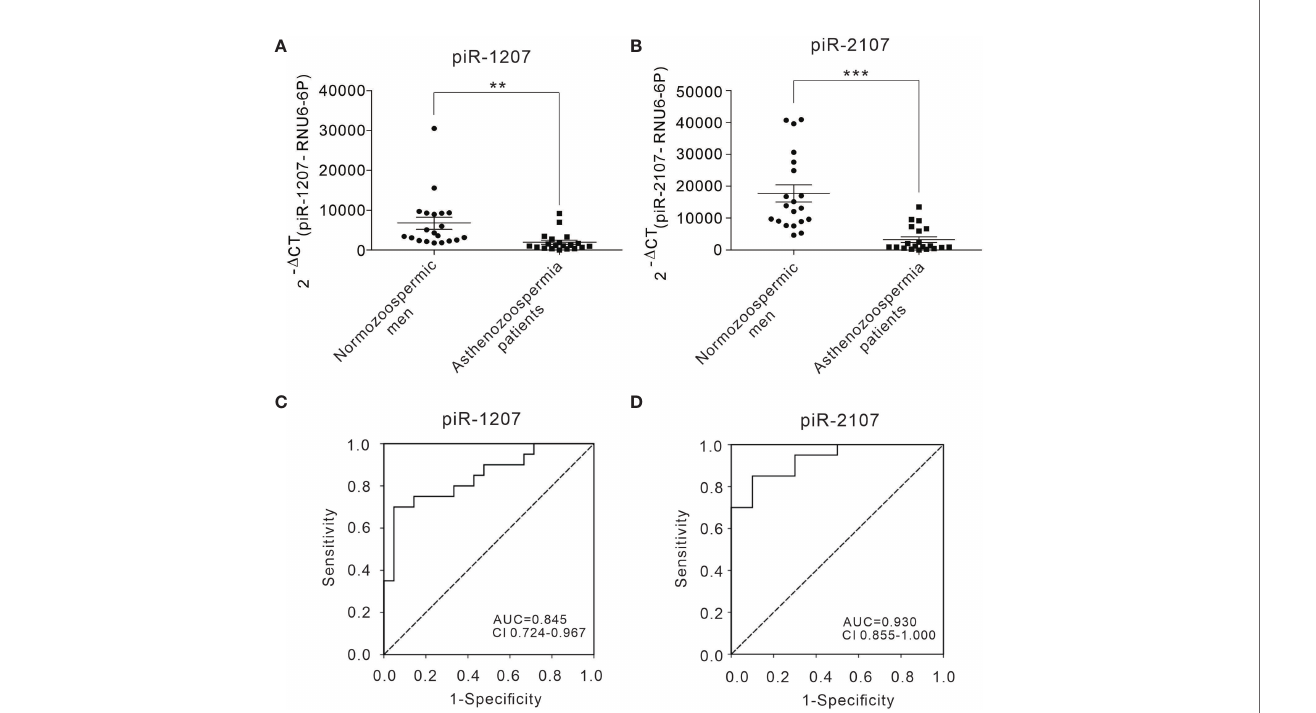
FIGURE 4 | Differential presence of piRNAs from sperms between asthenozoospermia patients and normozoospermic men and ROC curve analysis. (A, B) The relative level of piR-1207 and piR-2107 were determined by quantitative RT-PCR in the sperms of asthenozoospermia patients (n=20) compared with those in the sperms of normozoospermic men (n=20). (C, D) ROC curve for the piR-1207 (C) and piR-2107 (D) to separate asthenozoospermia patients from normozoospermic men. **p < 0.01; ***p <